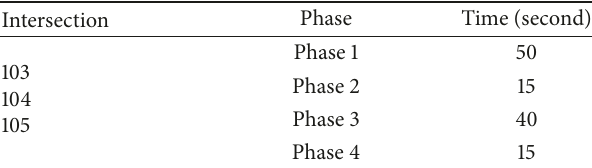
Table 1: Intersection time